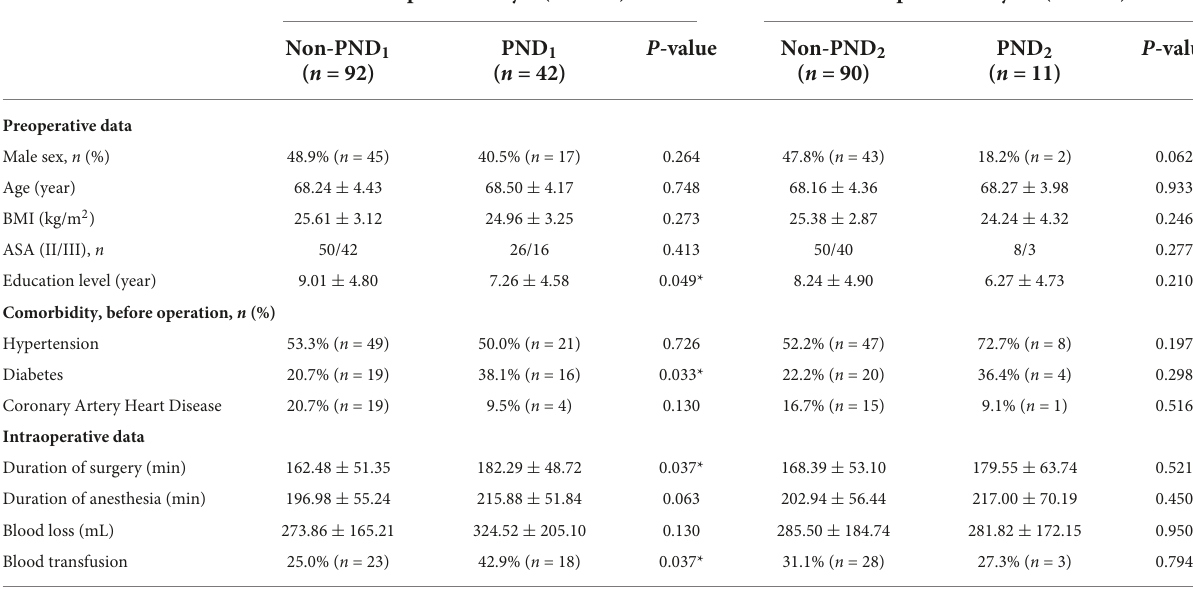
TABLE 1 Demographic data at baseline for patients with/without